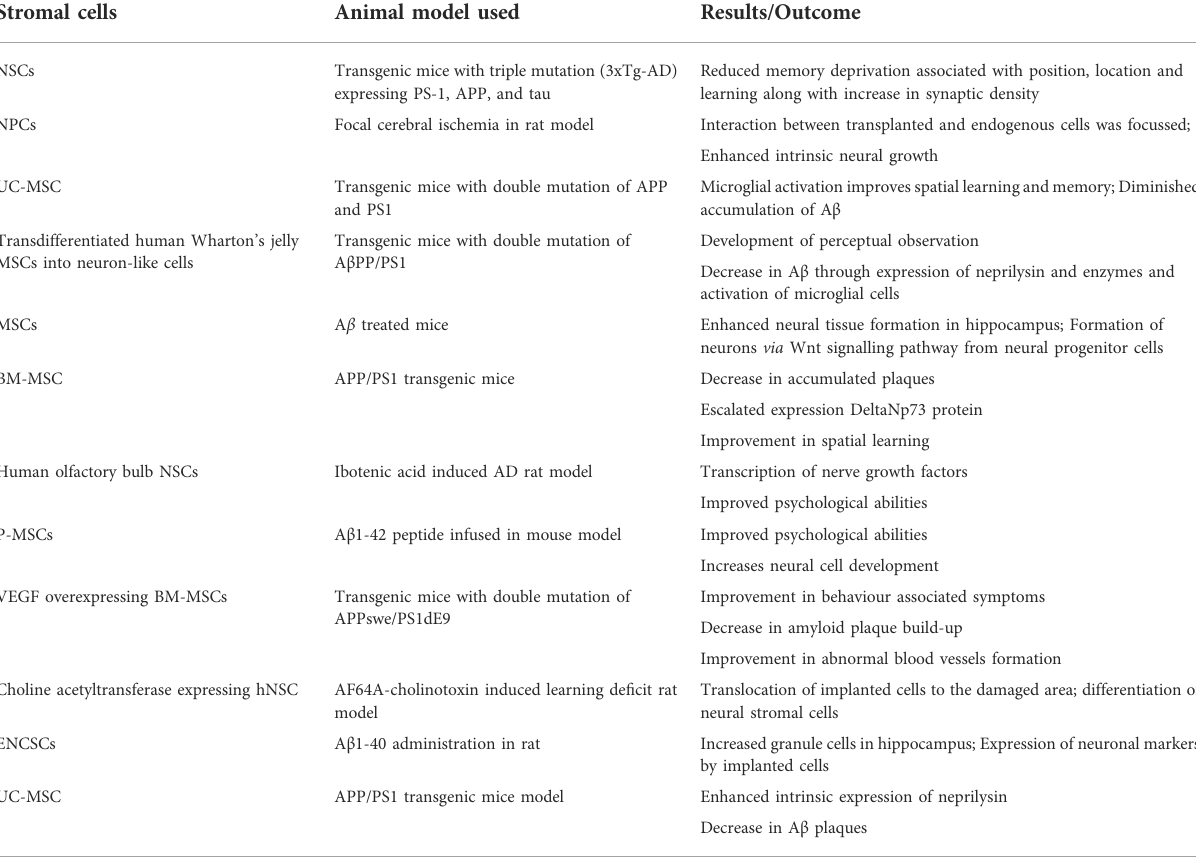
TABLE 1 Laboratory trials of stromal cells in the treatment of AD. Stromal